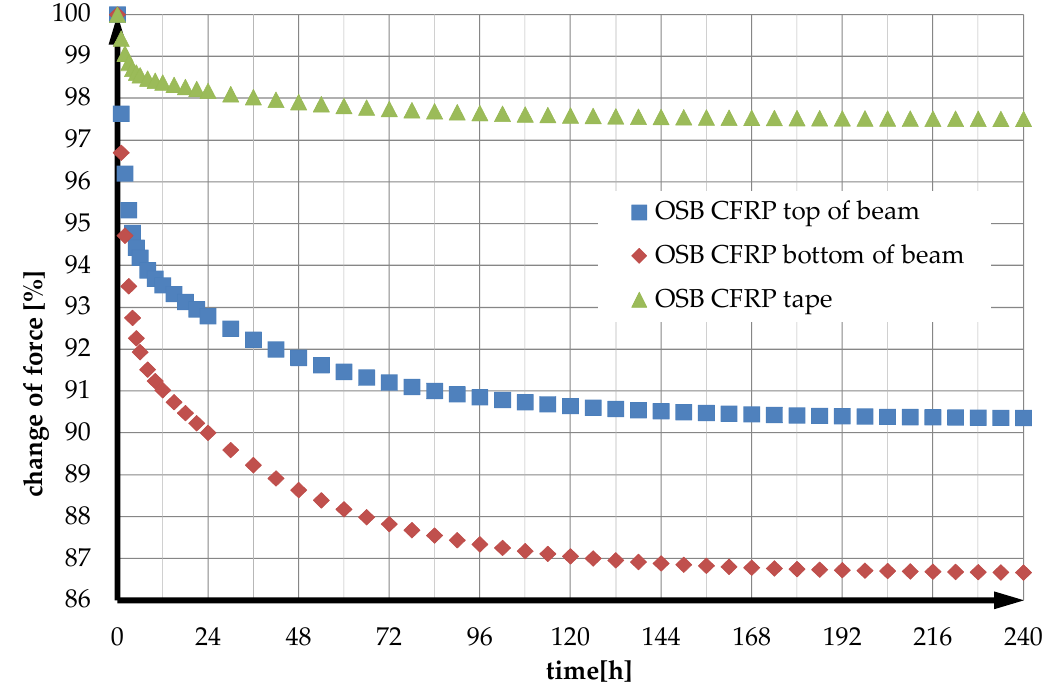
Figure 5. Stress redistribution and relaxation in the beam and the reinforcing strip’s tensile (bottom) and compressive (top) zones.